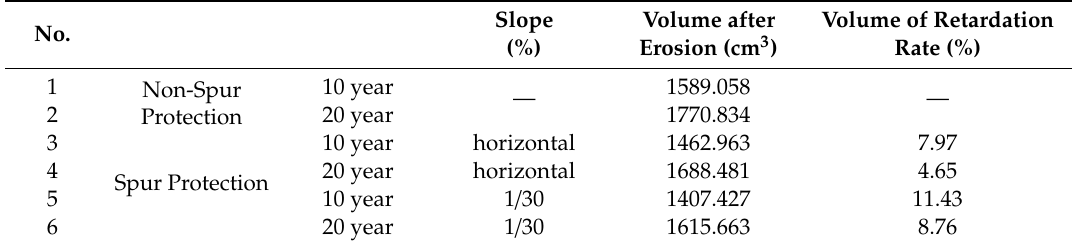
Table 2. The volume retardation rate on the slope of horizontal and 1 / 30 with spur protection and normal bend scour